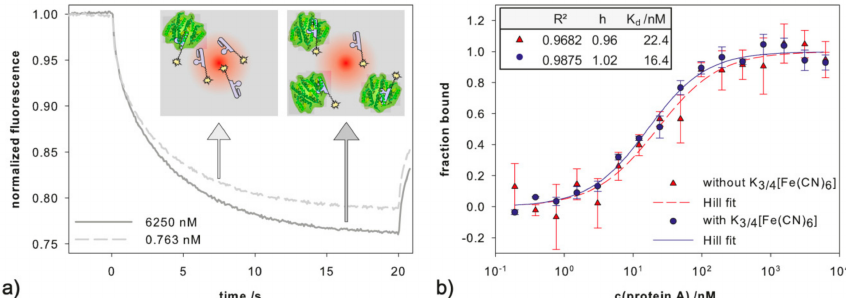
Figure 5. ( a ) Microscale thermophoresis (MST) curves for a low (0.763 nM, dashed line) and a high (6250 nM, solid line) protein A concentration with 38.5 nM labeled PAA (MST power 40%, LED power 100%); ( b ) Binding curves of recombinant protein A with aptamer in absence (red triangles) and presence (blue circles) of 2 mM ferri-/ferrocyanide measured in triplicates—the lines represent the Hill